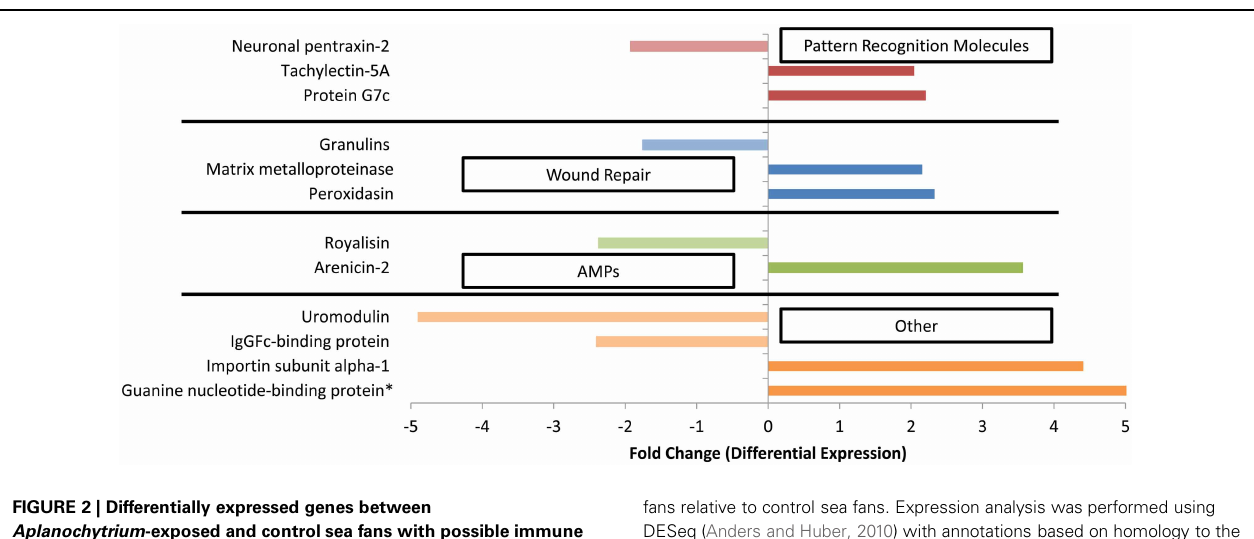
FIGURE 2 | Differentially expressed genes between Aplanochytrium -exposed and control sea fans with possible immune functions ( p < 0 . 05). Positive and negative values represent genes that were up- or down-regulated, respectively, in Aplanochytrium -exposed sea